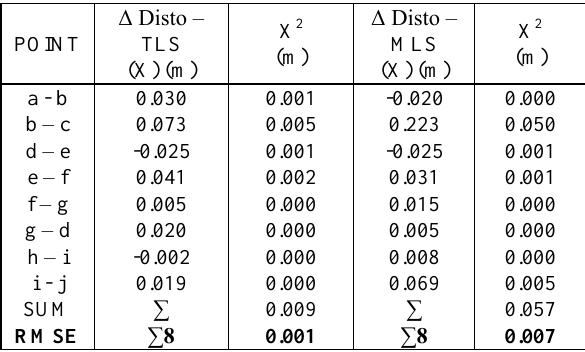
Table 2. Comparison measurement between Distometer with TLS and MLS